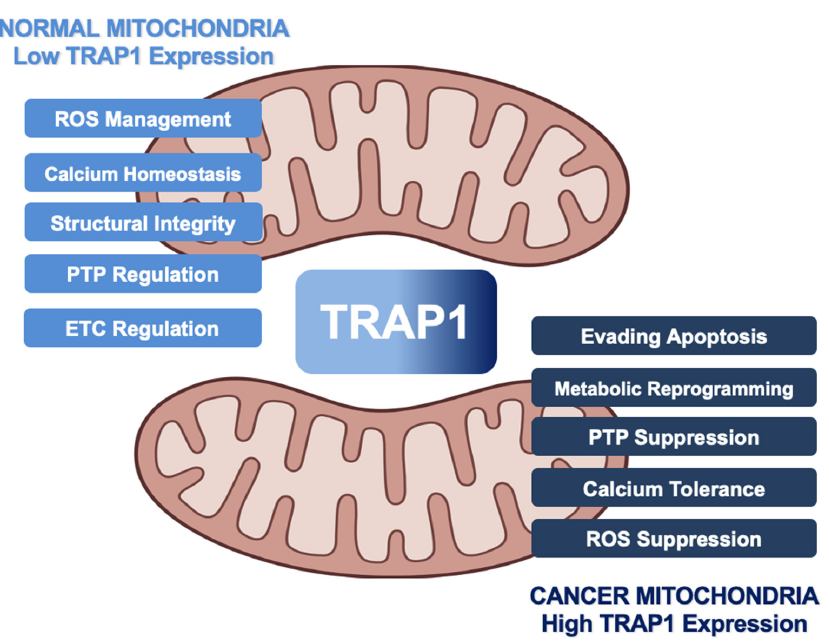
Figure 2. Role of human TRAP1 in mitochondria of normal cells and cancer cells. Normal expression levels (light blue) lead to TRAP1 regulation of ROS and calcium levels, integrity of cristae, function of ETC, and oversight of the PTP. As TRAP1 expression increases (dark blue), mitochondria lose calcium sensitivity, downregulate ROS, and prevent PTP opening, leading to metabolic reprogramming and evasion of apoptosis in cancer.